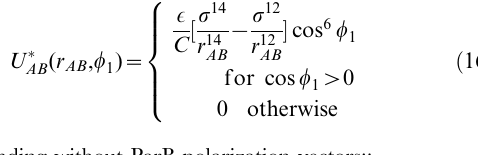
Figure S2 Dependence of translocation velocity, v ParB , on the density of ParA filaments within the ParA bundle. For ParA bundles of equal diameter, d & 6 a , but different numbers of ParA filaments, the translocation velocities are approximately equal. Thus, v ParB is insensitive to the density of filaments in the ParA bundle. Figure S3 Snapshots of a simulation with a ‘‘ParA tube’’. The ParA filaments in the ParA bundle are arranged cylindrically. The snapshots are slightly rotated into the page and the thin black circle indicates the base of the cylinder. Translocation of the ParB polymer is insensitive to whether the ParA filaments are arranged as a tube or as a bundle. Depolymerized ParA monomers are not shown. Figure S4 Dependence of translocation velocity, v ParB , on the stiffness of the ParB polymer. In our standard model, the ParB polymer is flexible, and the bending stiffness is K S ~ 0 k B T . In order to simulate a stiff ParB polymer, we apply the bending potential in Eq. 11 to the ParB polymer. v ParB is insensitive to the bending stiffness over the observed range of K S . Figure S5 Force-velocity relation for ParB polymer translocation in our simulations. In these simulations, an external force, f ext = 2 , pulls on each of the two ends of the ParB polymer, thus opposing depolymerization-driven translocation. Translocation of the ParB polymer is unperturbed when subjected to external pulling forces up to f ext & 7pN . Figure S6 Steady-state ParA concentration profiles for tip-binding-only and side-binding models. Steady-state ParA concentration is plotted versus position relative to the center of mass of the ParB polymer, which is located at z ~ 0nm and indicated by the dotted green line. When ParB binds only to the tips of ParA filaments, the center of mass of the ParB polymer (dotted green line) localizes near the edge of the ParA filament concentration gradient (dashed black curve). This enables the ParB polymer to easily escape the ParA concentration gradient and detach from the ParA bundle due to thermal noise. However, when ParB can bind to the sides of ParA filaments, the ParB polymer penetrates further into the ParA bundle, and thus the center of mass (green) of the ParB polymer is localizes near the center of the ParA concentration gradient (dashed red curve). Thus, the ParB polymer is not susceptible to falling out of the ParA gradient and detaching from the ParA bundle due to thermal noise. Figure S7 Snapshots of a simulation in which several ParA filaments remain after the ParB polymer has translocated. If the initial spacing, b , of the ParA filaments in the bundle is large, the ParB polymer may translocate by disassembling some, but not all, of the ParA filaments. In